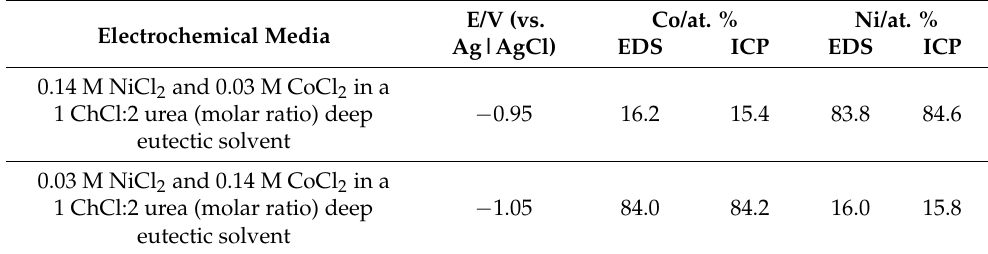
Table 1. Electrochemical media, deposition conditions, and elemental composition of prepared